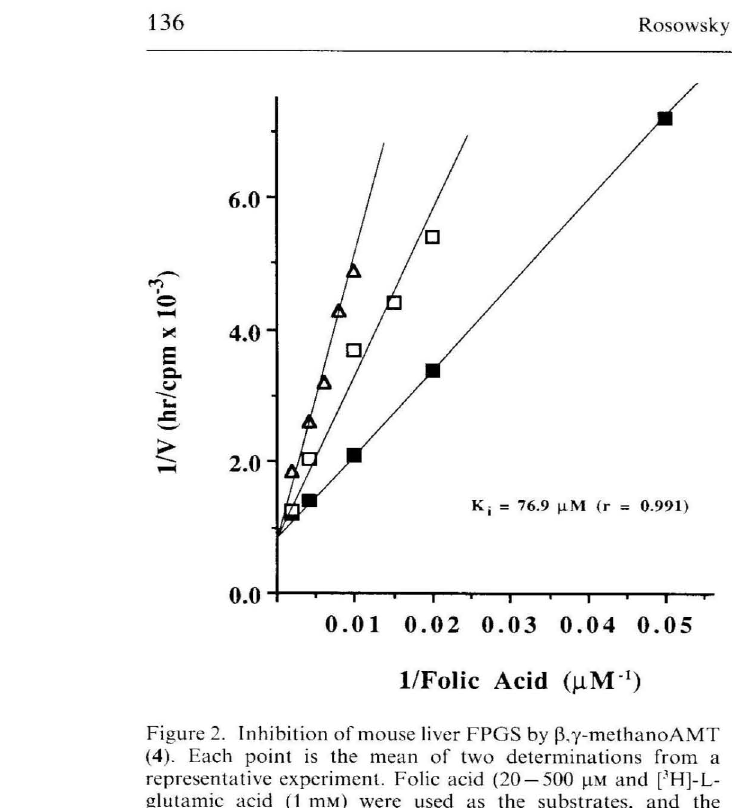
Figure 2. Inhibition of mouse liver FPGS by (3,y-methanoAMT (4). Each point is the mean of two determinations from a representative experiment. Folic acid (20-500 llM and ['H]-L glutamic acid (1 mM) were used as the substrates, and the inhibitor concentrations were 0 (_), 50 (D), and 150 llM ( D